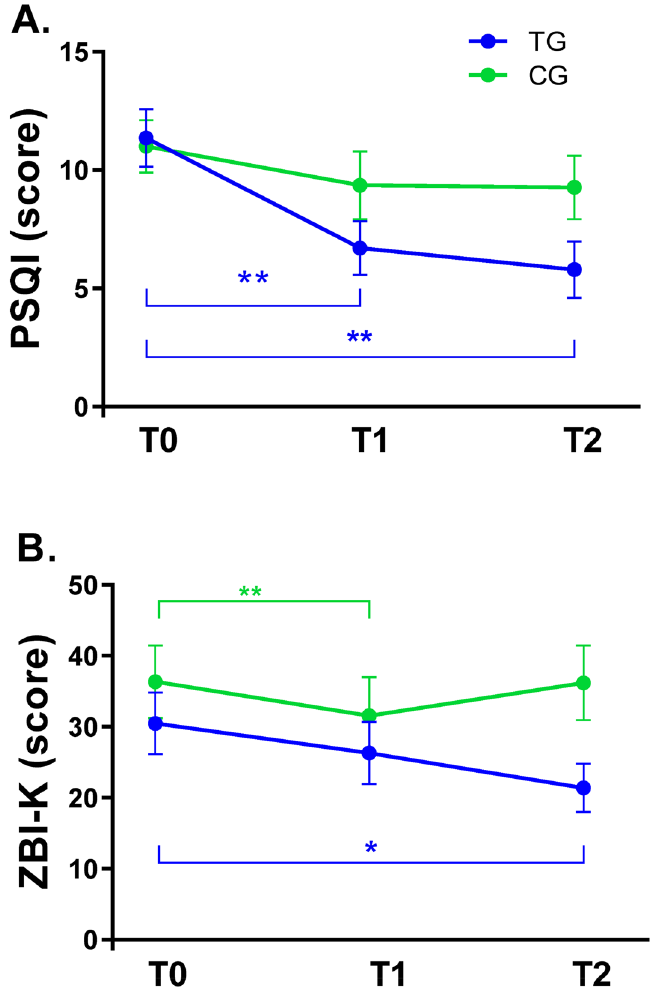
Figure 3. Pittsburgh Sleep Quality Index (PSQI) ( A ) and Korean version of Zarit Burden Interview (ZBI-K) ( B ) scores before and after timed blue enriched white light treatment in the treatment group (TG) (N = 14) and control group (CG) (N = 11). T0 baseline, T1 immediate post-treatment, T2 4 weeks after the end of the 2 weeks of light treatment. The mean scores for the PSQI and ZBI-K at T1 and T2 were compared to those at T0. The plots indicate mean ± SEM, *p < 0.05, **p < 0.01 (paired